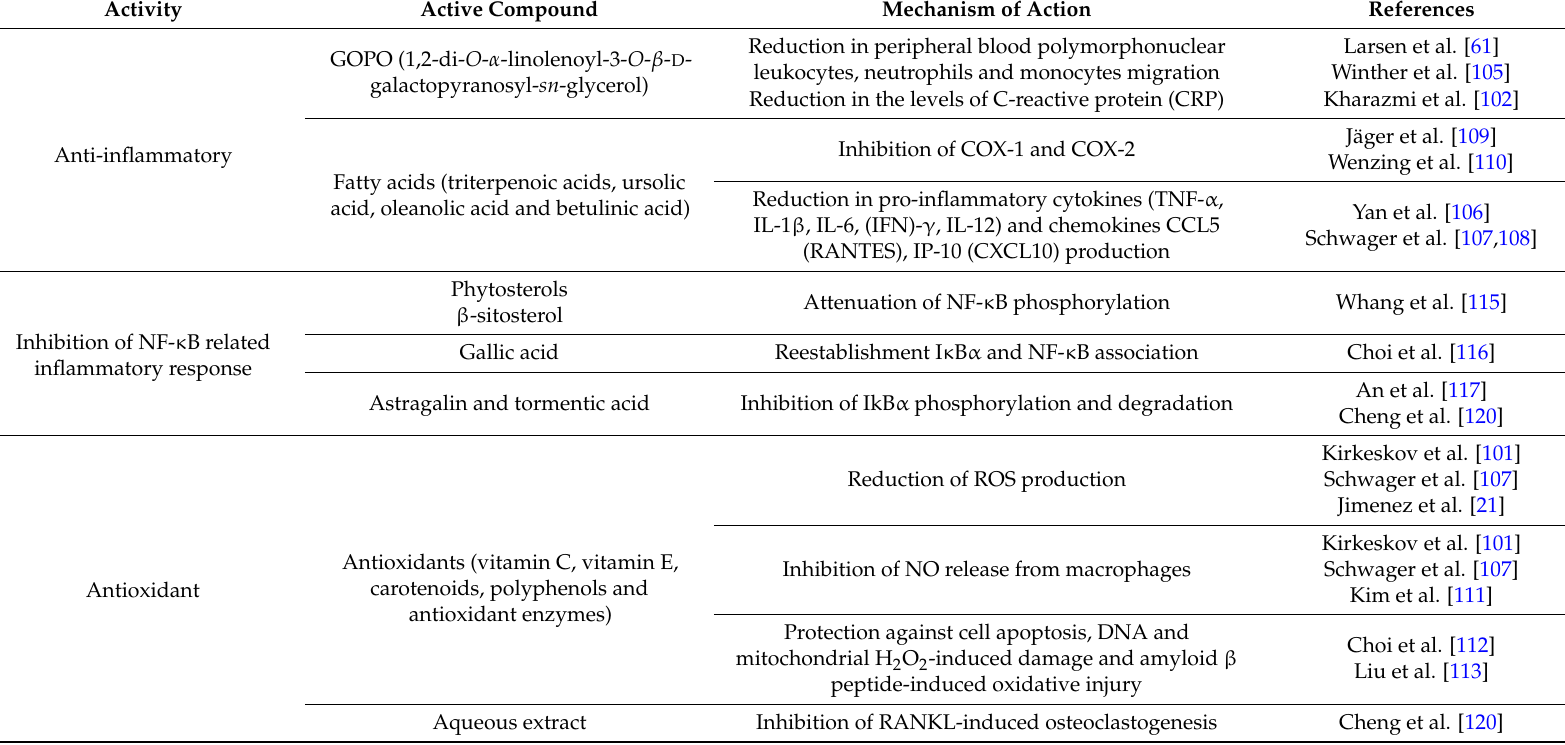
Table 2. Bioactive compounds of Rosa spp. and their mechanisms of action in rheumatoid